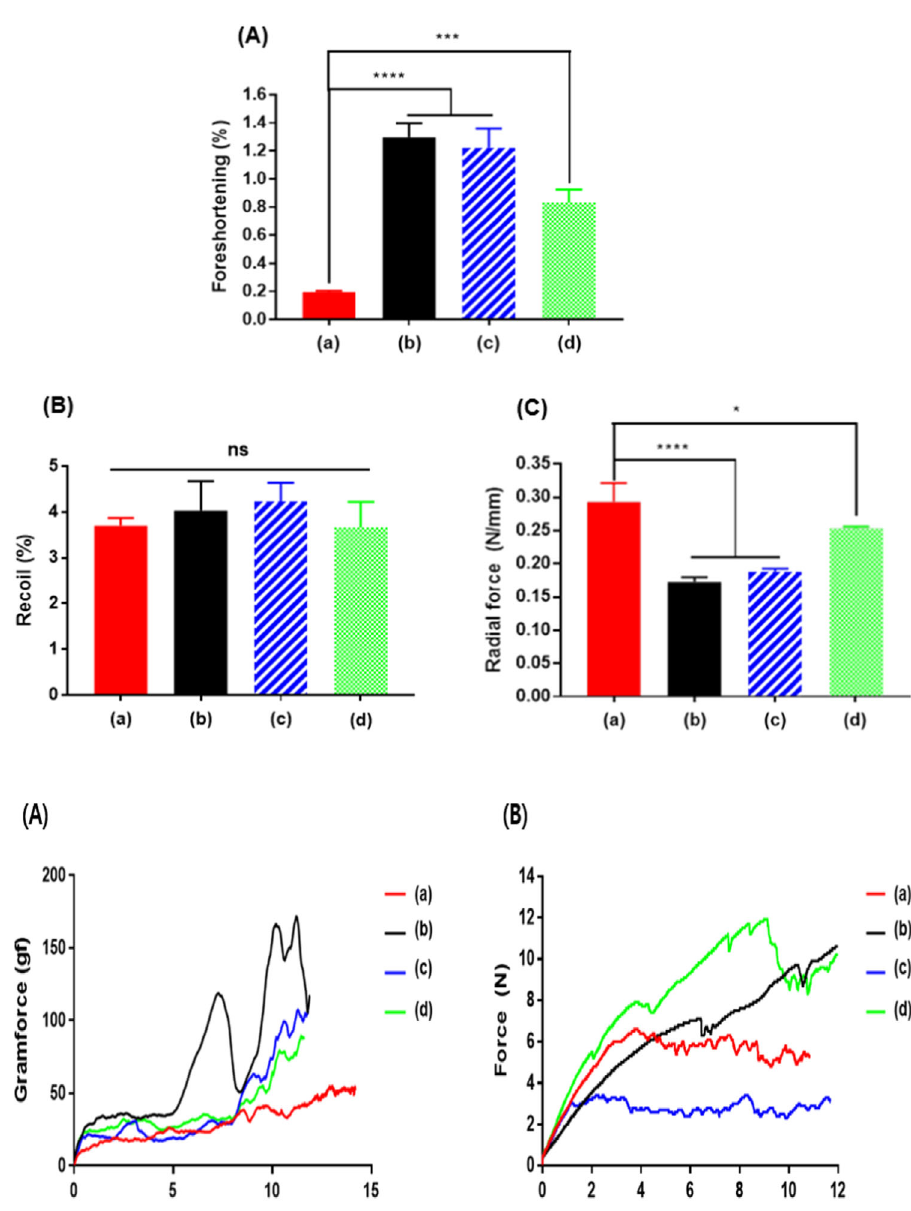
Fig. 3 Mechanical properties of D + Storm ® DES (Drug-eluting stent) (a), Synergy ™ (b), Orsiro ® (c), and Xience sierra ™ (d). A Foreshortening, B